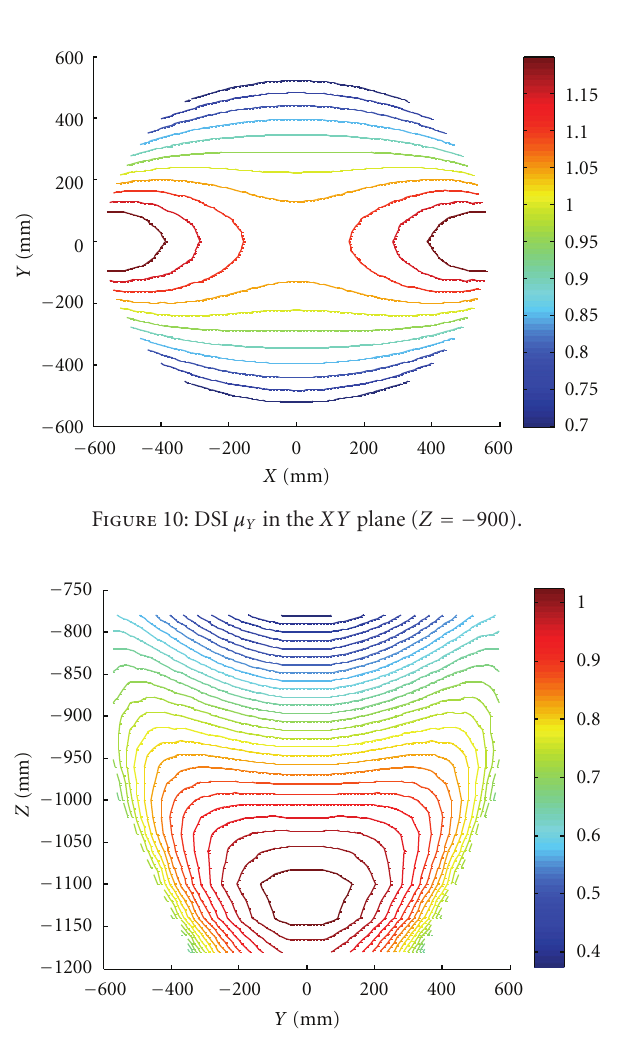
Figure 11: Manipulability index μ t in the YZ plane ( X = 0).